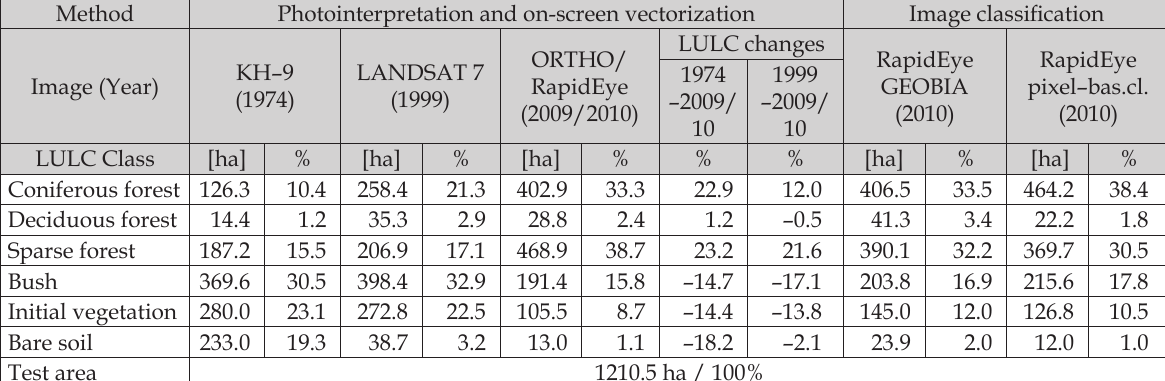
Table 1. The distribution of LULC classes in the test